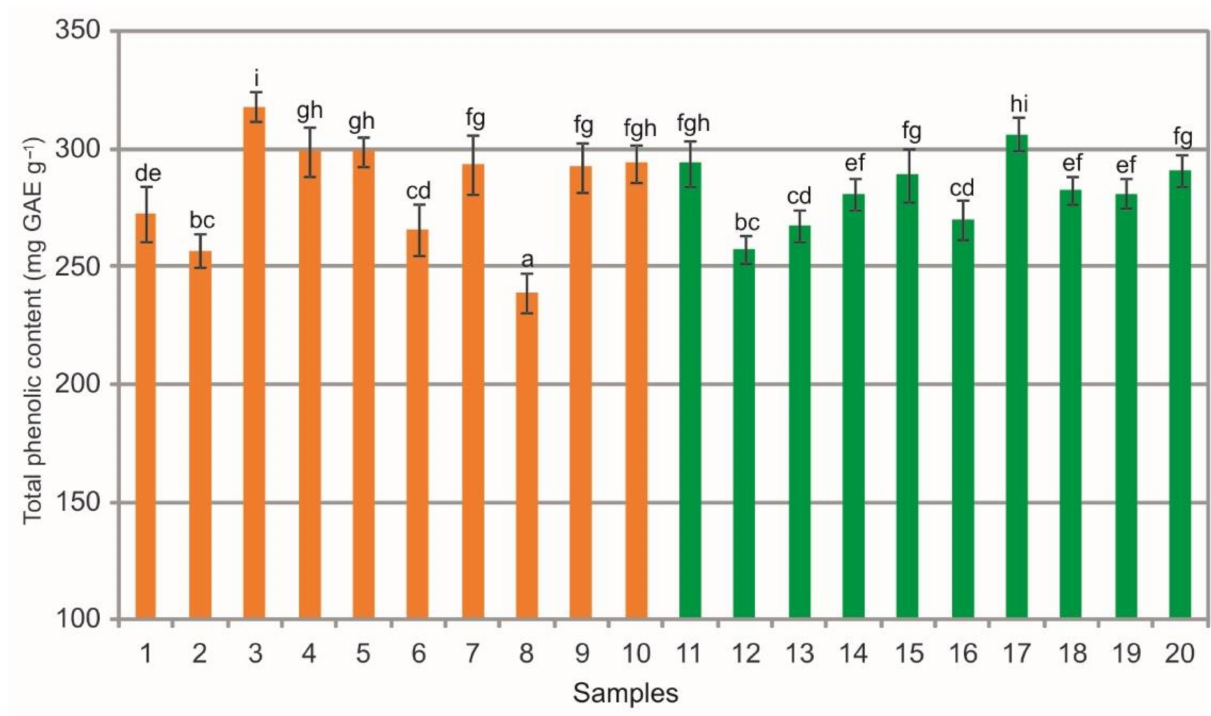
Figure 9. Total phenolic content (mg GAE g − 1 ) contents in leaf extracts from bearberry plants collected in heathland populations (orange) and in pine forest populations (green). For each site, data are mean and SD. The values designated by the different letters are significantly different (U Mann-Whitney test, p <